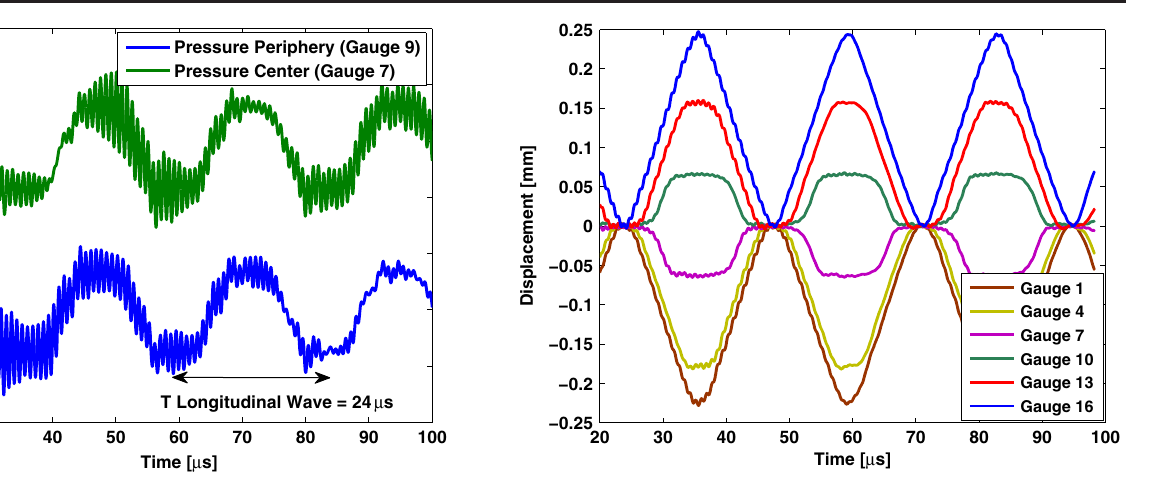
FIG. 6. Pressure response at the center (gauge 7) and periphery (gauge 9) during 20 μ s – 100 μ s under infinitely elastic material assumption (reached pressures only for qualitative information). The plot clearly shows the presence of high frequency radial and low frequency − 24 μ s period- longitudinal waves.